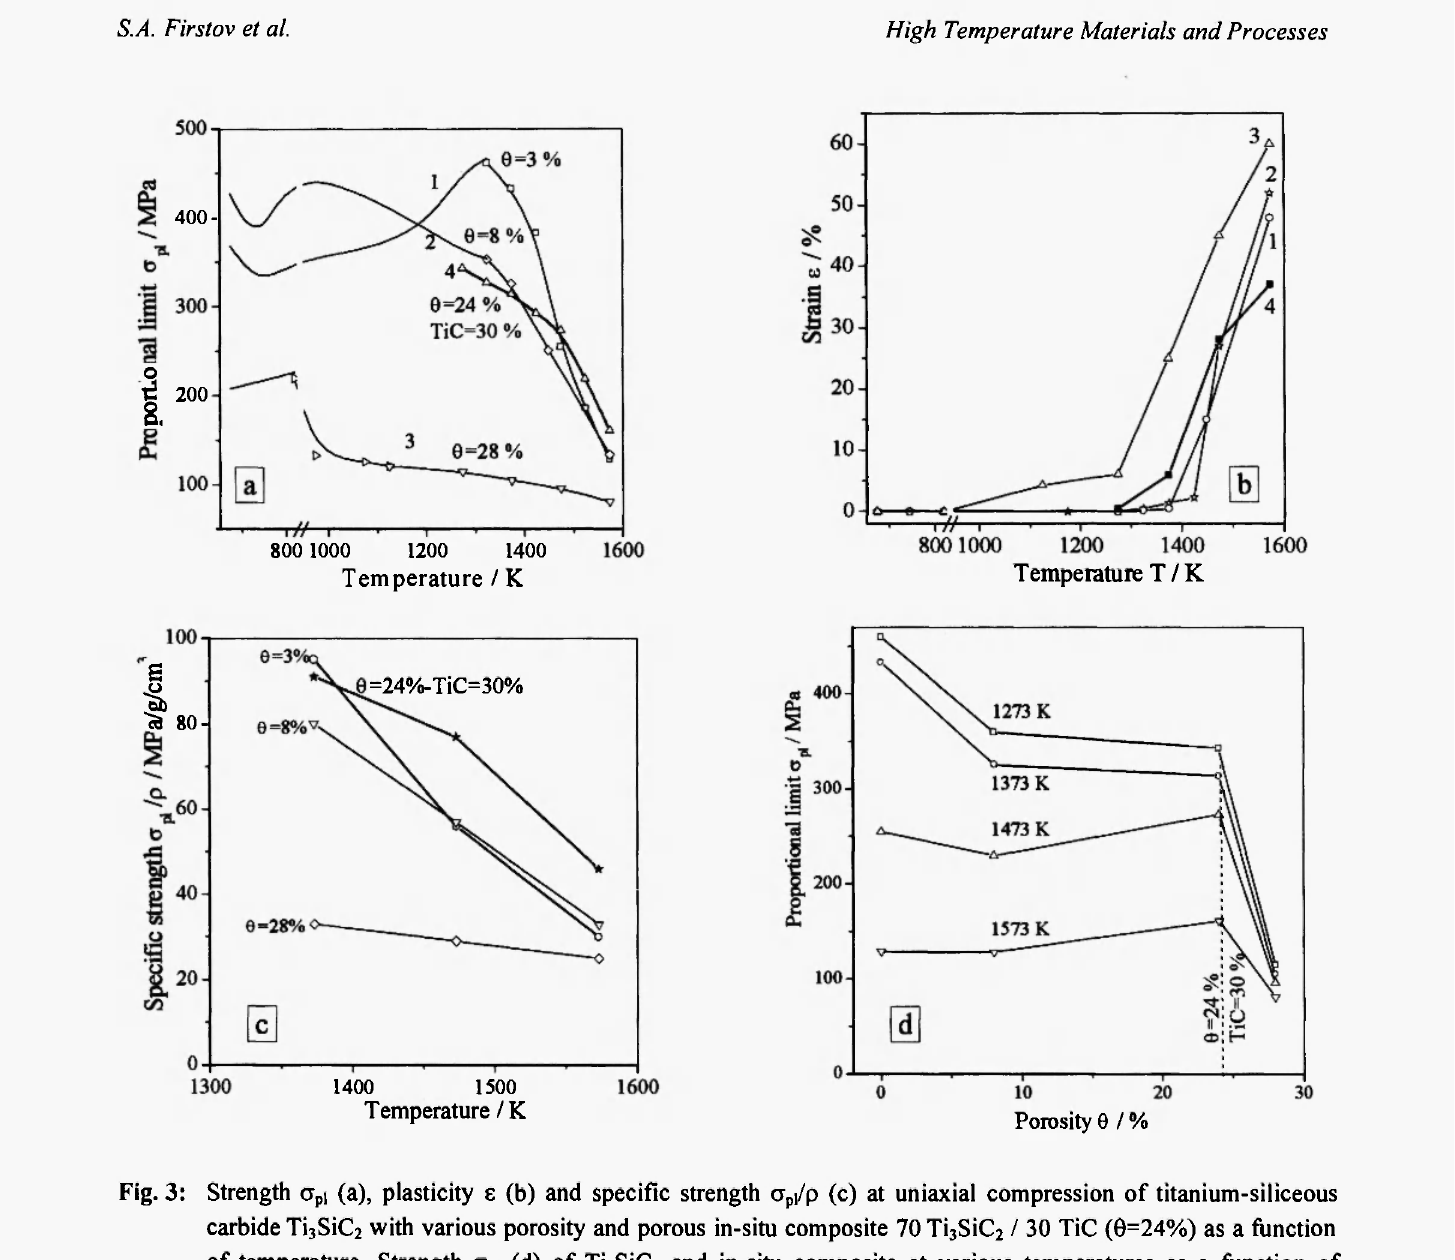
Fig. 3: Strength σ ρ ι (a), plasticity ε (b) and specific strength σ ρ ι/ρ (c) at uniaxial compression of titanium-siliceous carbide Ti 3 SiC 2 with various porosity and porous in-situ composite 70 Ti 3 SiC 2 / 30 TiC (0=24%) as a function of temperature. Strength σ ρ ι (d) of Ti 3 SiC 2 and in-situ composite at various temperatures as a function of